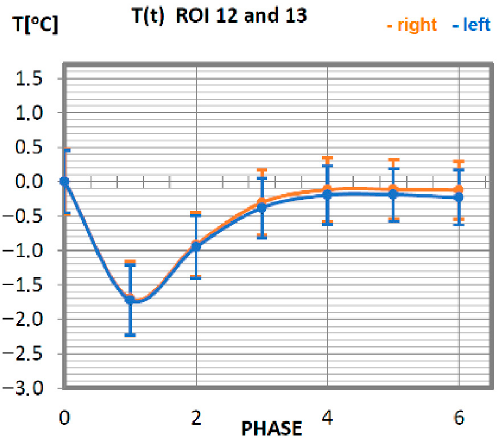
Figure 8. Temperature time (0 to 6 phase of training according to methods) changes of the trapezius muscle obtained before and after training using a rowing ergometer for the studied group of athletes.